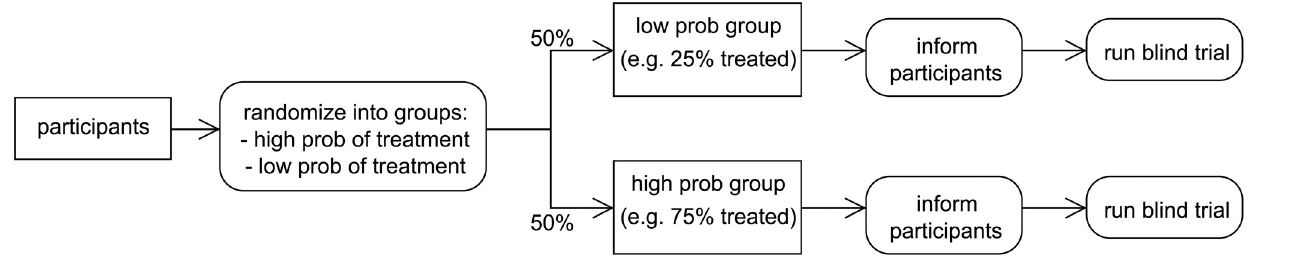
Fig 1. A Two-by-Two Blind